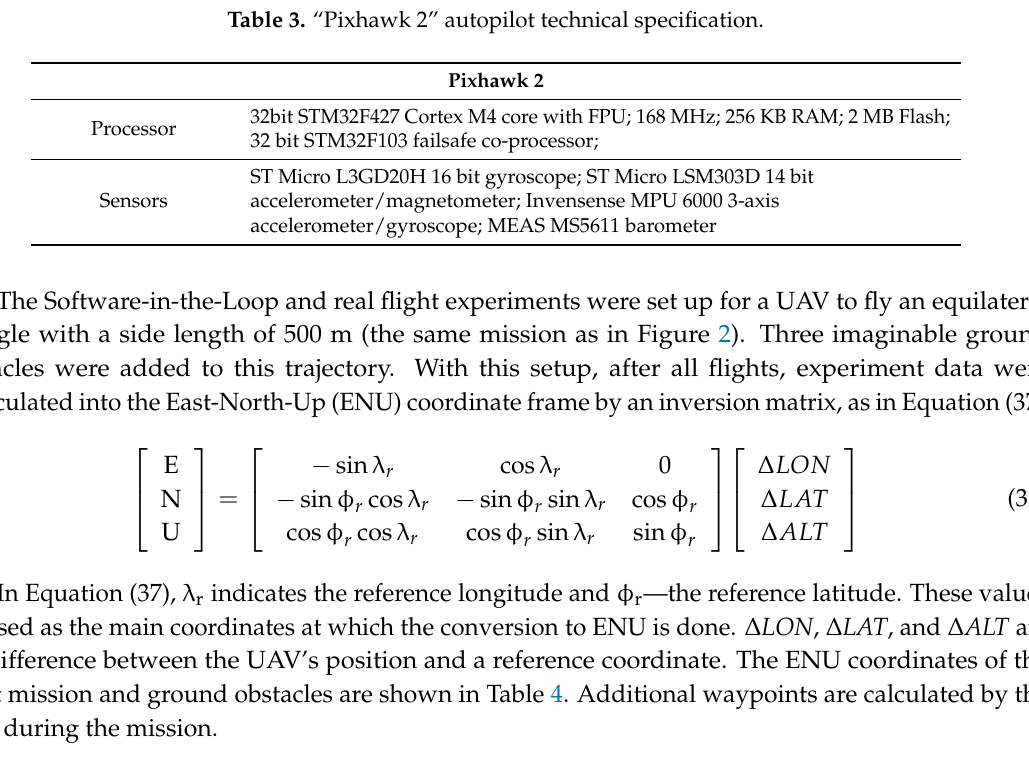
Table 4. ENU coordinates of the mission points and ground